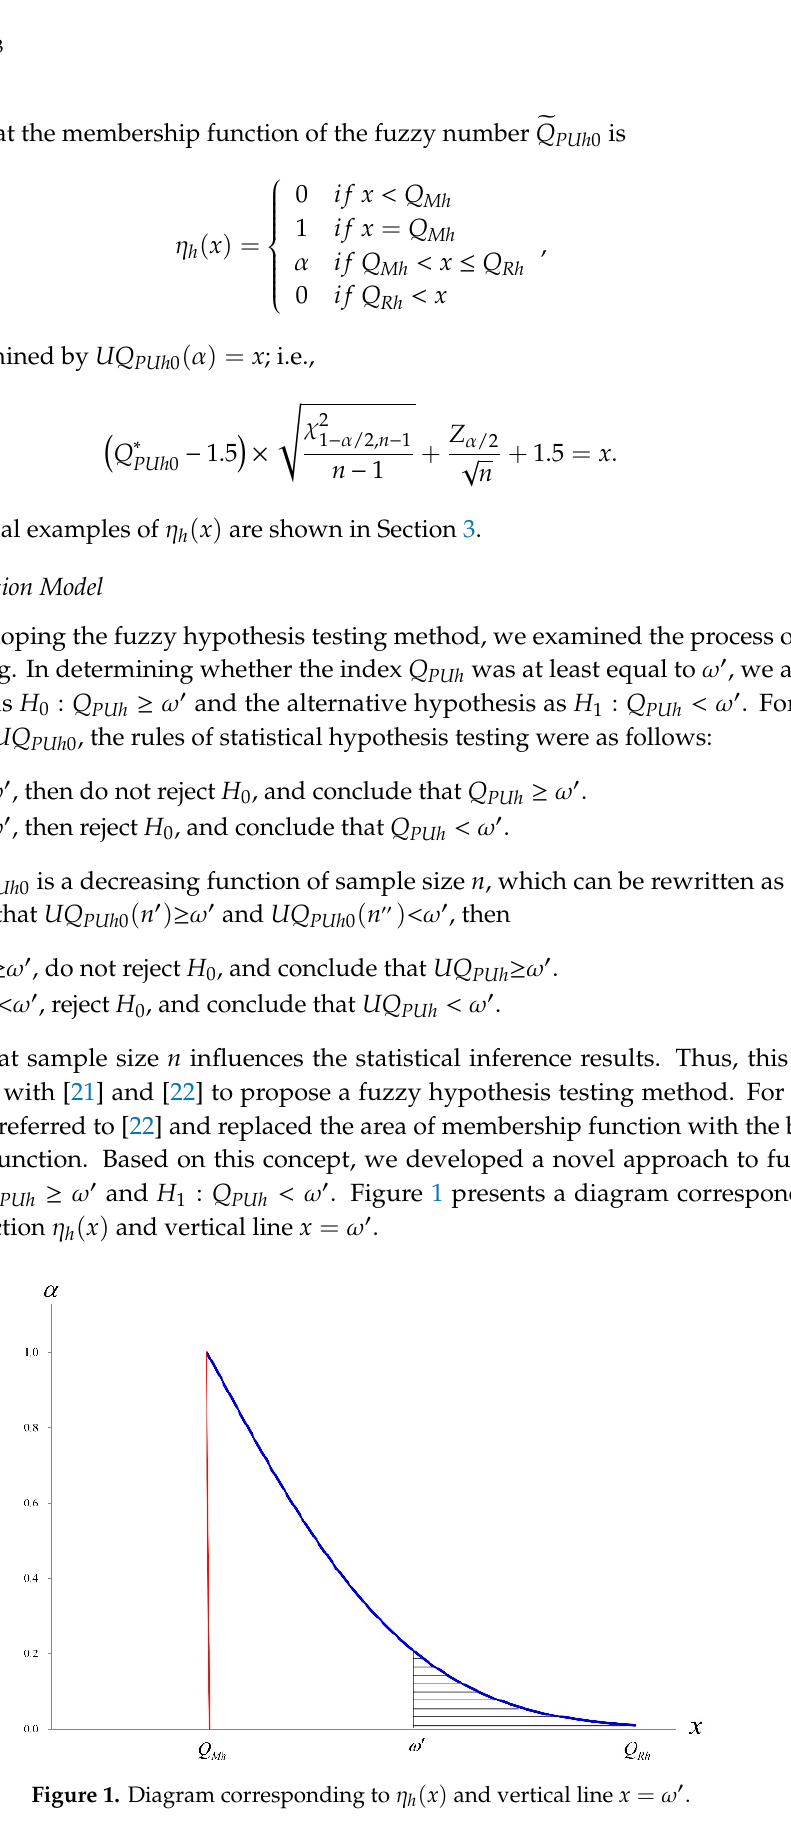
Figure 1. Diagram corresponding to ( )